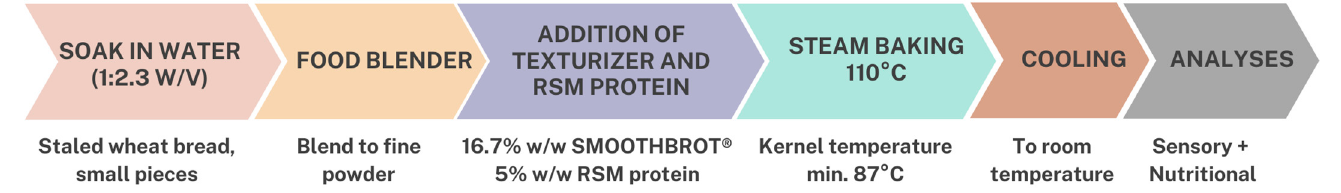
Figure 2. Flow-chart of TM chicken breast and TM carrot preparation.